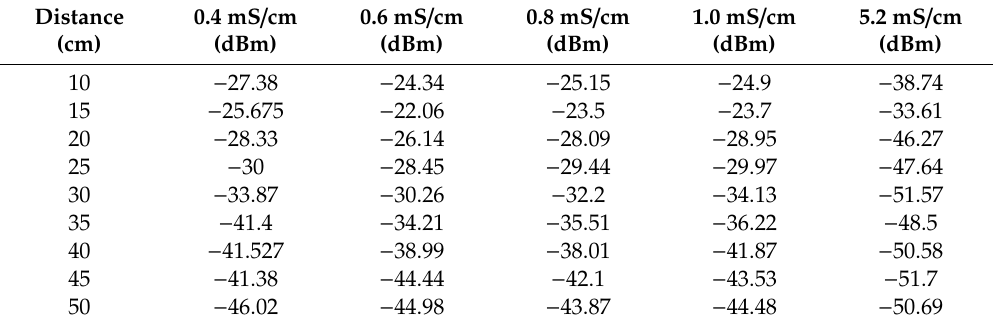
Table 2. Signal losses for distances between 10 cm and 50cm at di ff erent conductivity levels.